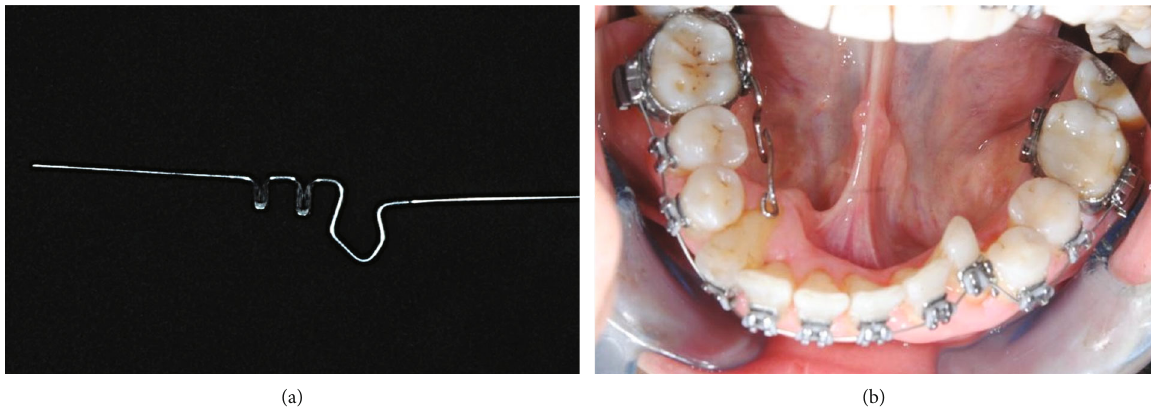
Figure 4: Orthodontic lingual sectional (a); lingual sectional inserted on lingual tubes (b).